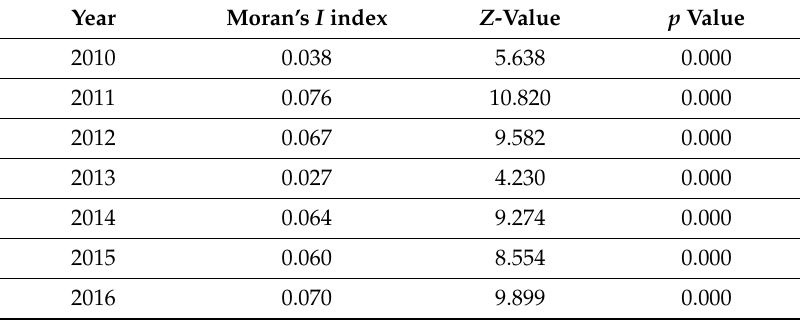
Table 4. The Moran’s I index of ULUE in China from 2010 to